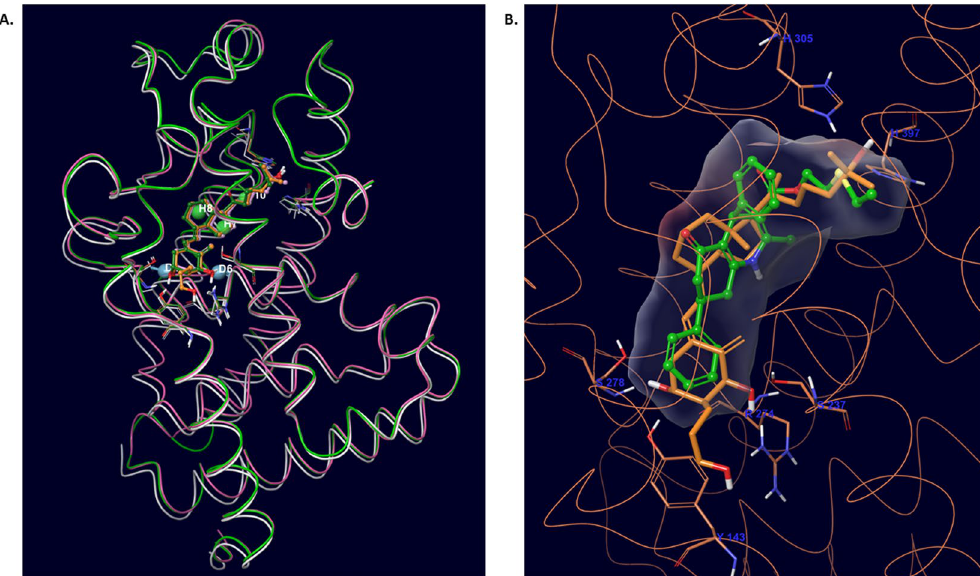
Figure 1. In silico screens of novel VDR agonists. ( A ) Overlay of three co-crystallized structures of vitamin D receptor (PDB codes: 1DB1, gray; 2HB7, green; 3CS6, pink), represented as thin tubes, their co-crystal structure represented as ball and stick, and pharmacophore (DDHHH.30) hypothesis (three hydrophobes, H7, H8 and H10 shown as green balls; two donors, D4 and D6 shown as blue balls with vector), depicting their potential interactions with binding site residues; ( B ) X-ray pose of co-crystal ligand in 2HB7 structure (orange, thick stick) and early lead compound VDR 4 (green, ball and stick) as aligned during pharmacophore screen (LBVS). According to ePharmacophore, the energetically important sites are H7 and H8 located in seco-steroidal fused C-D rings (corresponding to bicyclic ring in VDR 4), and two donor sites located on A-ring hydroxyls of 1,25-D 3